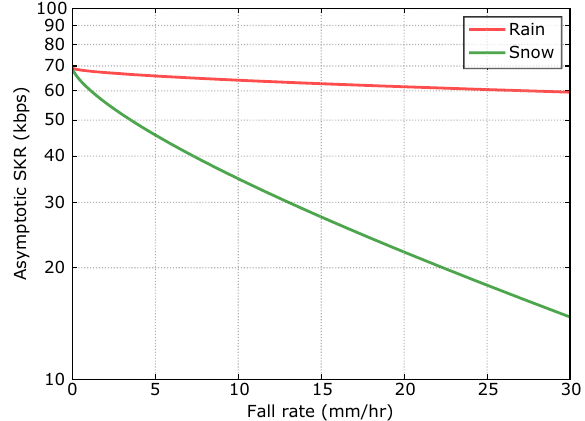
Fig. 6 Simulation of the decreasing of the asymptotic secret-key- rate under bad weather condition. The simulations are obtained by supposing to perform our best run under different rain or snow fall rates.